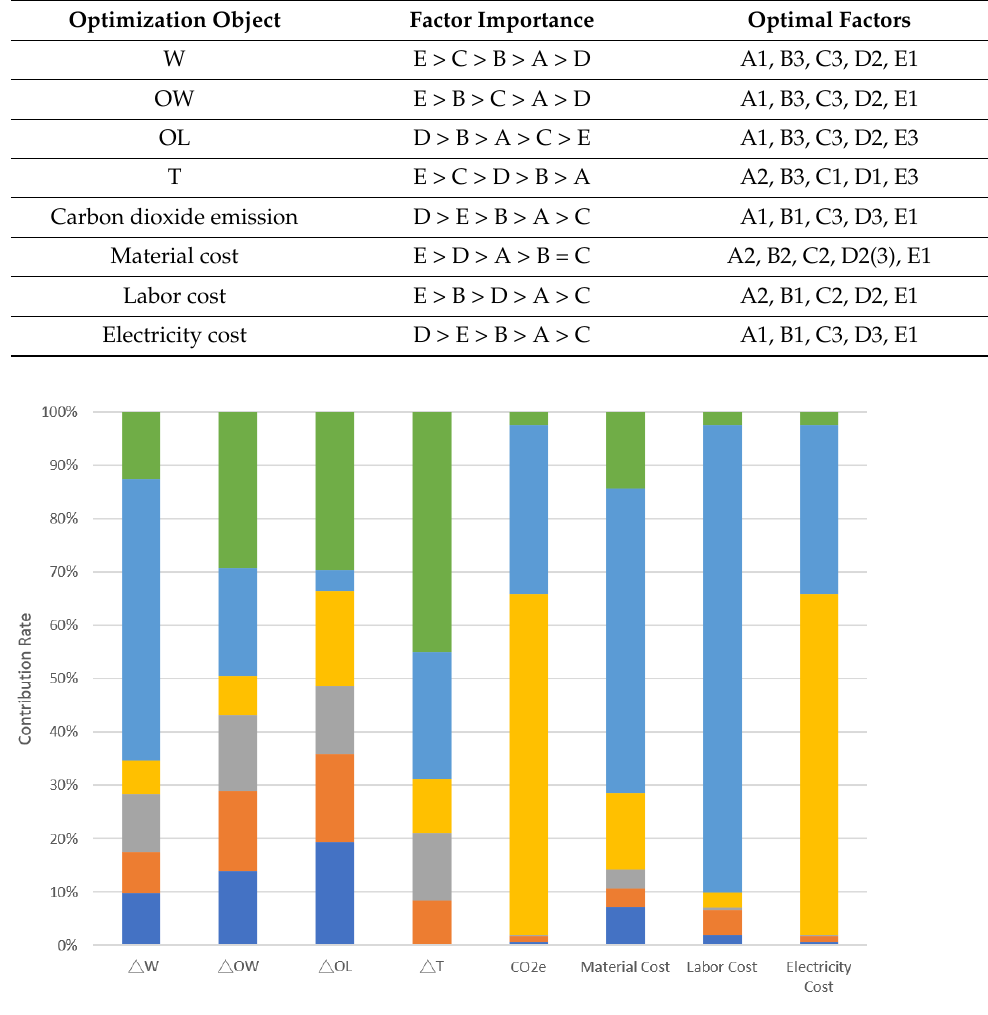
Table 5. Optimal factors of all single objectives.